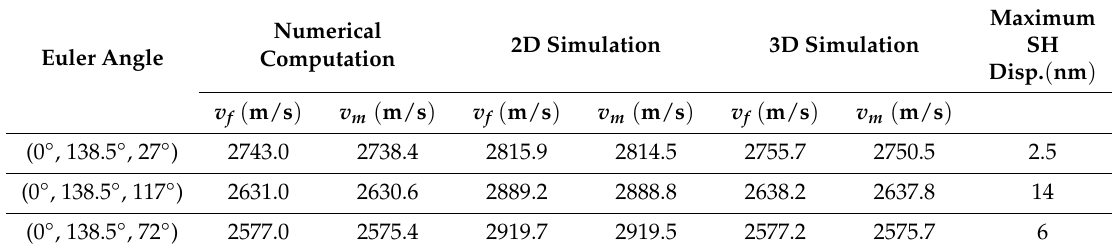
Table 1. Summary of calculated parameters of LGS using di ff erent